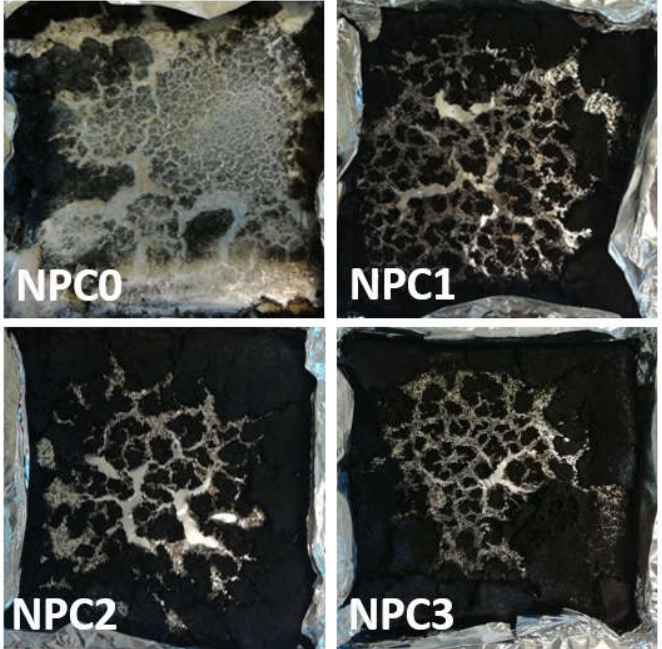
Figure 10. Digital photos of char residue for PLA-based NPCs after cone calorimeter test.